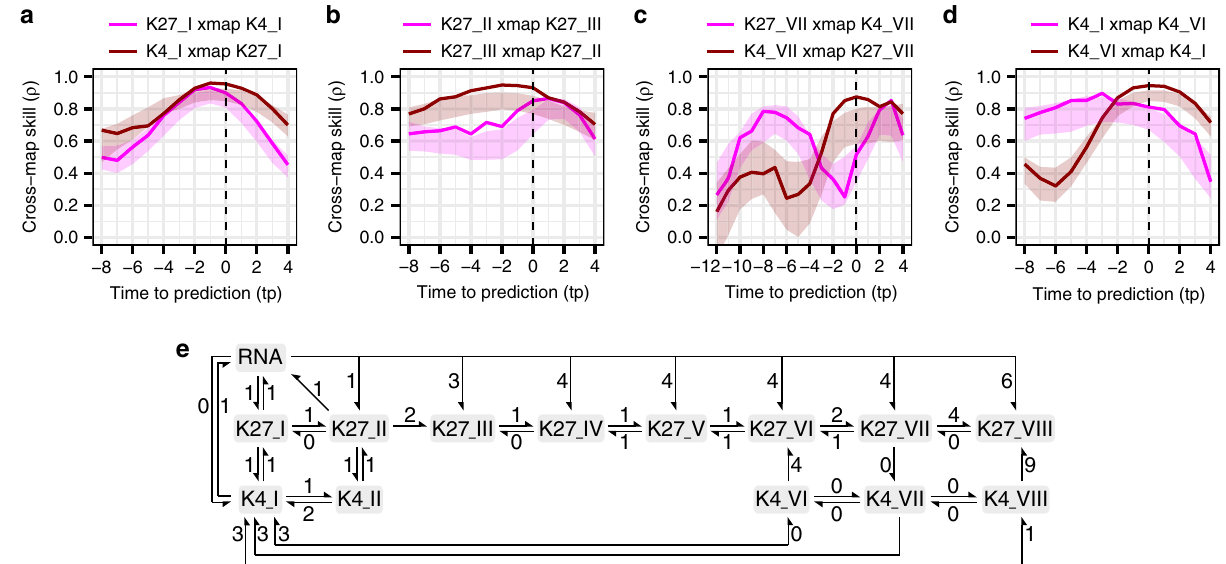
Fig. 4 Empirical dynamic modelling of AhgFLC histone modi fi cation and mRNA levels. a – d Convergent cross-mapping (CCM) between AhgFLC H3K27me3 at amplicon I (K27_I) and K4_I ( a ), between K27_II and K27_III ( b ), between K27_VII and K4_VII ( c ), and between K4_I and K4_VI ( d ). The cross-map skill ( ρ ) is shown as the function of time to prediction (tp). In the top keys, e.g. ‘ K27_I xmap K4_I ’ represents that K27_I cross-map (or cross-predict) K4_I, indicating that the state of K4_I is predicted using the state of K27_I. Because CCM explores the signature of a causal variable in an effect variable, this prediction measures the effect of K4_I on K27_I. Solid lines represent the cross-map skill ( ρ ), and shaded regions represent the 95% intervals of 100 seasonal-surrogate time series. a Bidirectional causality between K27_I and K4_I was detected since both variables were the best predicted by each other at negative tp. b Unidirectional causality from K27_II to K27_III was detected since the best forecasting skill occurred at tp ≤ 0 only for ‘ K27_III cross-maps K27_II ’ . c Unidirectional causality from K27_VII to K4_VII was detected for the same reason as in b . d Bidirectional causality between K4_I and K4_VI was detected for the same reason as in a . e The causal network of AhgFLC H3K27me3, H3K4me3, and mRNA, illustrated based on the results of CCM. Arrows represent the directions of causality. The numbers next to the arrows represent the time lags (1 time lag = 2 weeks). Source data are provided as a Source Data fi